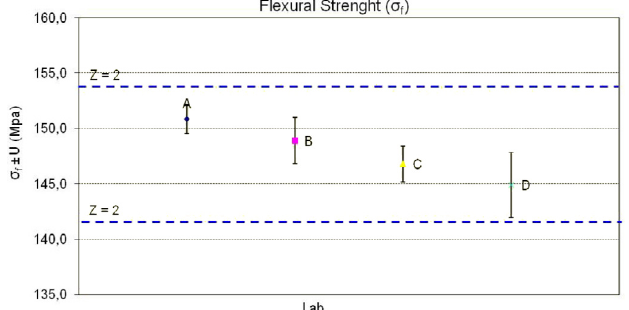
Fig. 5. Flexural strength ( σ f ) and uncertainty values for flex- ural testing of the participant laboratories.